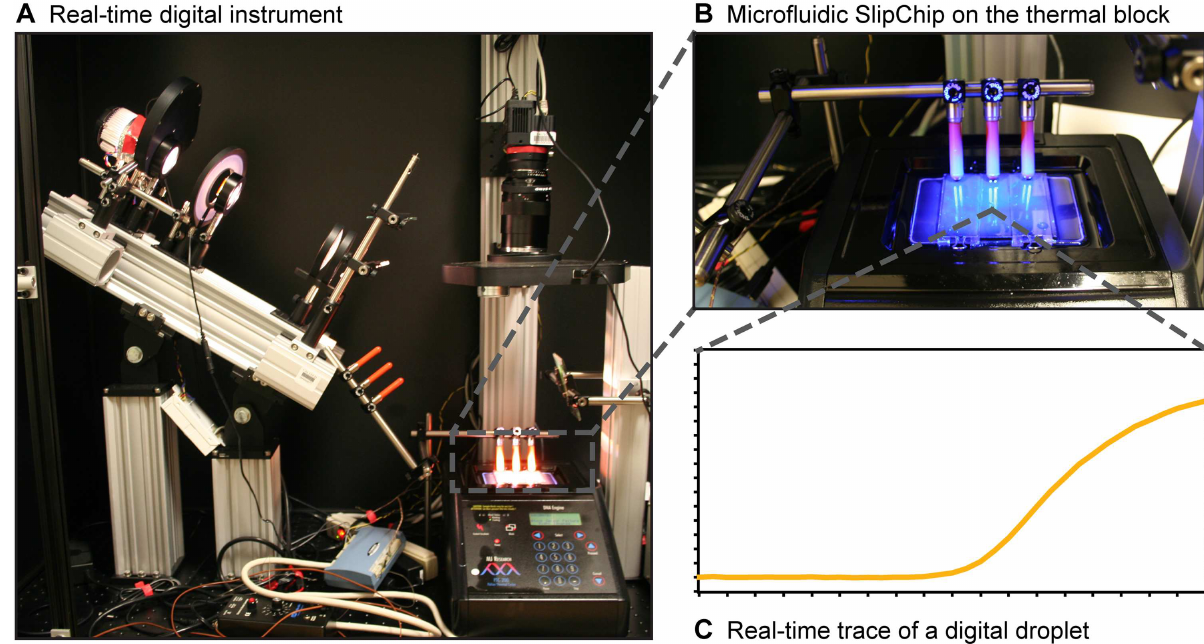
Fig 1. The large-format real-time instrument at different scales. (A) A photograph of the instrument in which its door has been removed for imaging; this door can be closed to block out light from the room. (B) A close-up view of the thermal block onto which the microfluidic devices are secured with a clamp to keep them in place. (C) A real-time trace of a digital reaction that was collectedover the course of a real-time digital experimentfrom a singlewell on a microfluidic device.